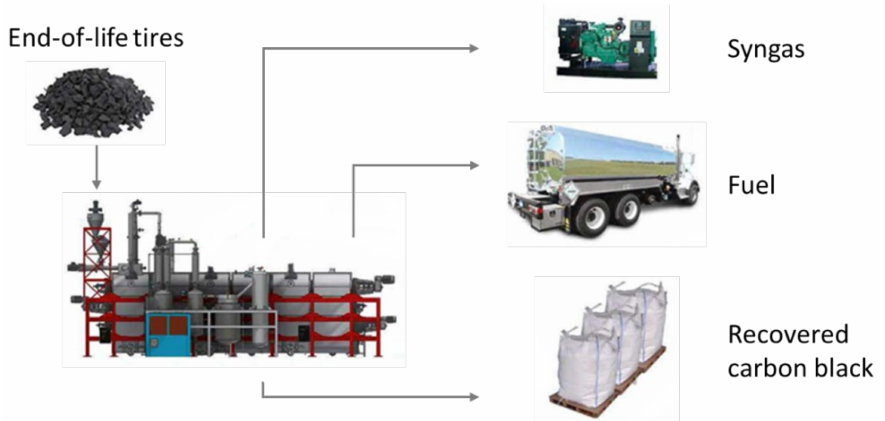
Figure 2. Schematic representation of ELT pyrolysis and ensuing